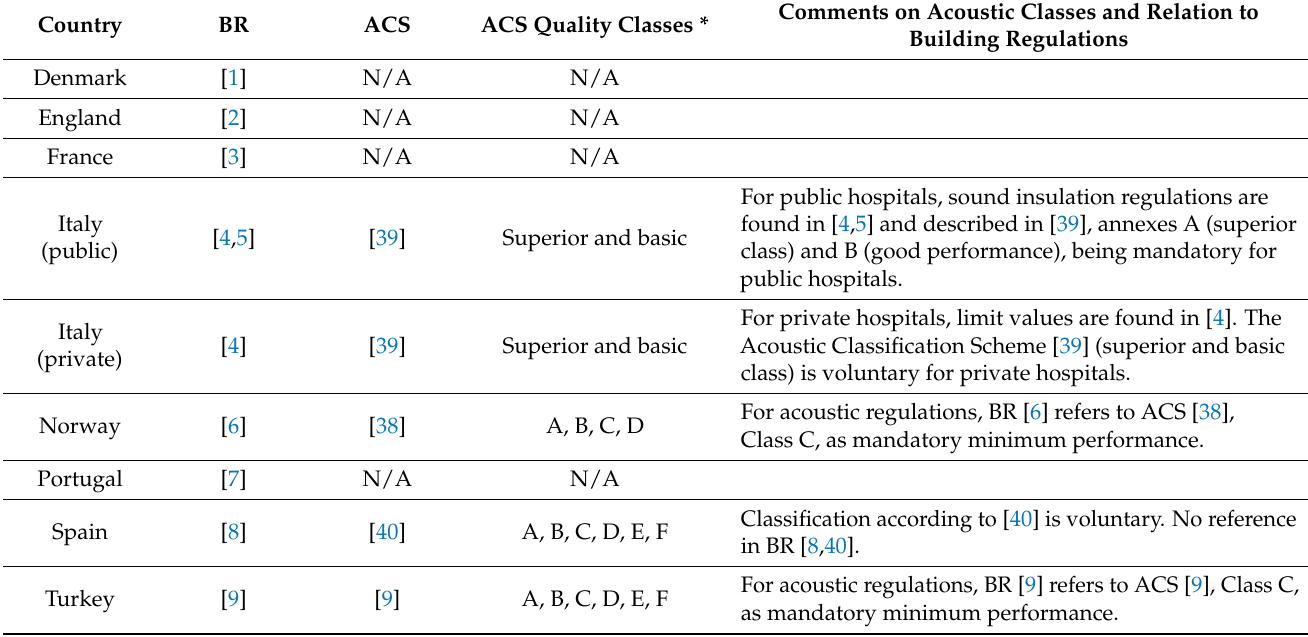
Table 1. Acoustic regulations for hospitals—Overview countries selected for a comparative study in Europe (November